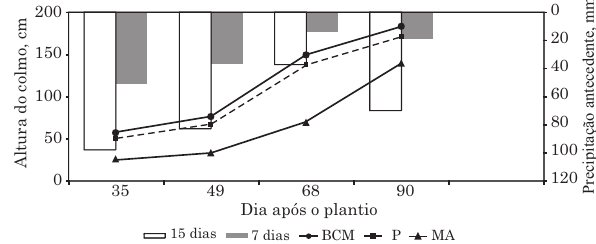
Figura 5. Variação da altura do colmo do milho, durante o ciclo da cultura, para os tratamentos de cobertura com palma (P), plantio morro abaixo (MA) e barramento com cobertura morta (BCM) e da precipitação antecedente (15 e 7 dias) ao